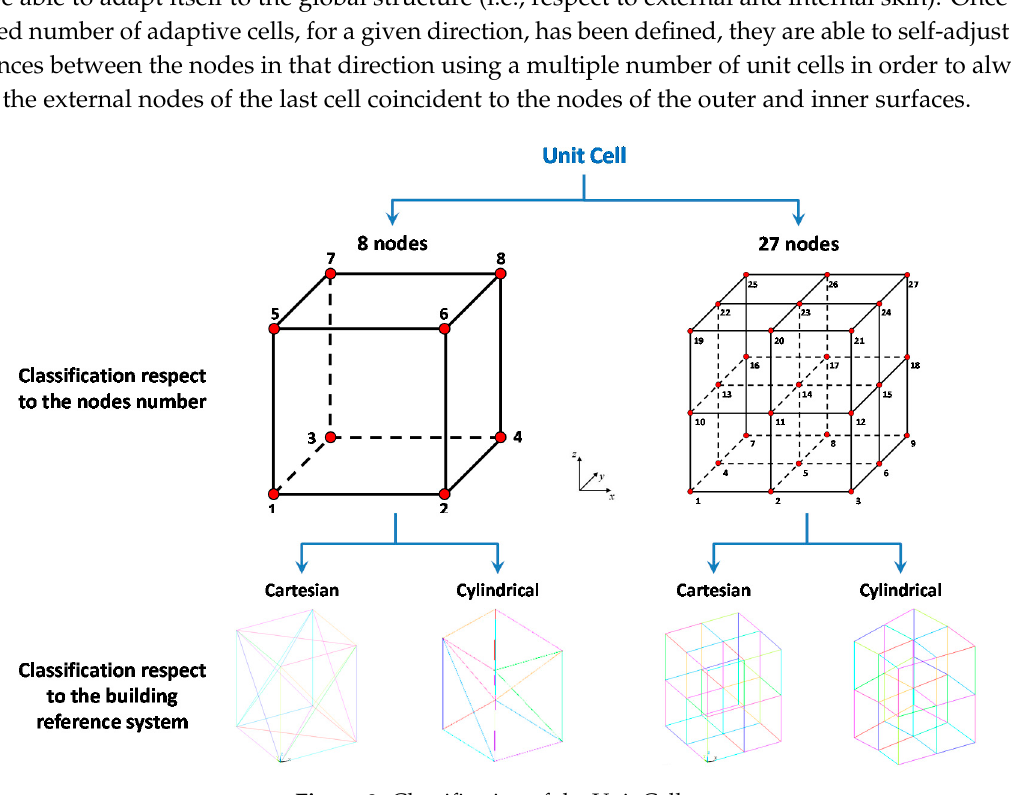
Figure 3. Classification of the Unit Cells.